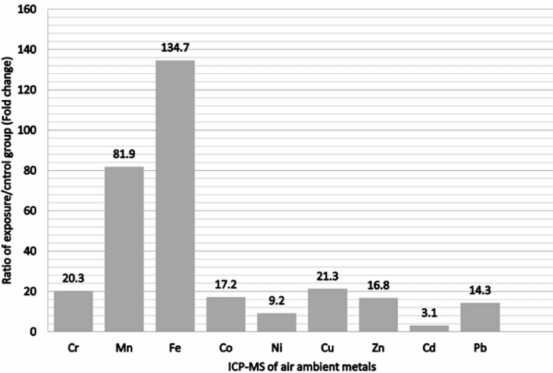
Figure 2. Ratio of metals of exposure/control group from personal air samples in the metal fumes particulate matter. Table 1. Characteristics of welding and office workers in 2-year